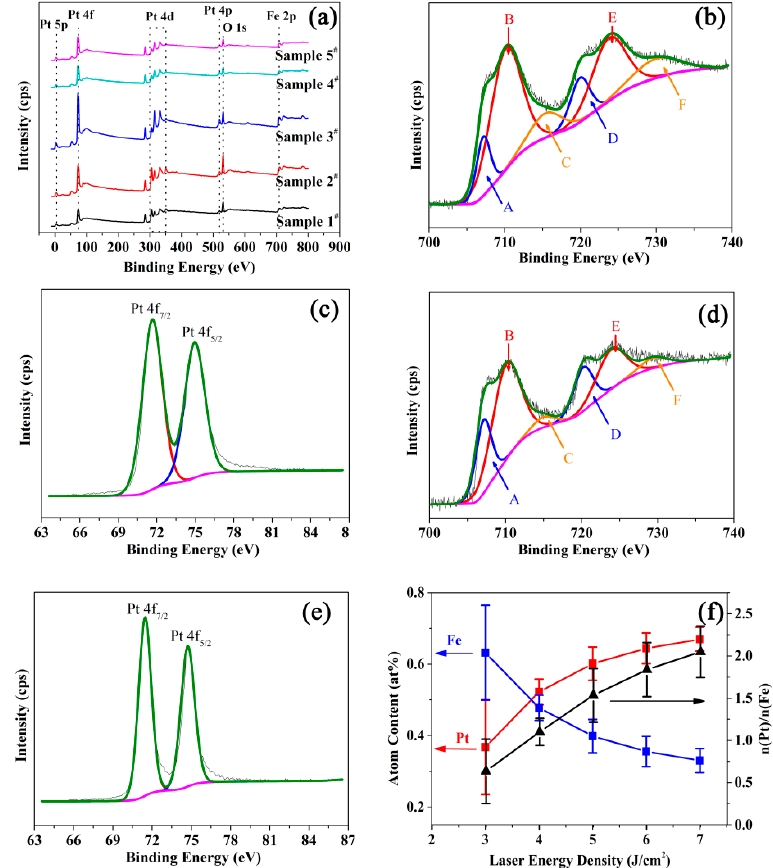
Figure 1. ( a ) XPS survey spectrum for FePt/MgO nanocomposite film, XPS spectrum for Fe 2p ( b , d ) and Pt 4f ( c , e ) for sample 1 # and sample 5 # , respectively. ( f ) atom content for Fe and Pt, and the Pt/Fe atom ratio for different samples calculated by XPS.